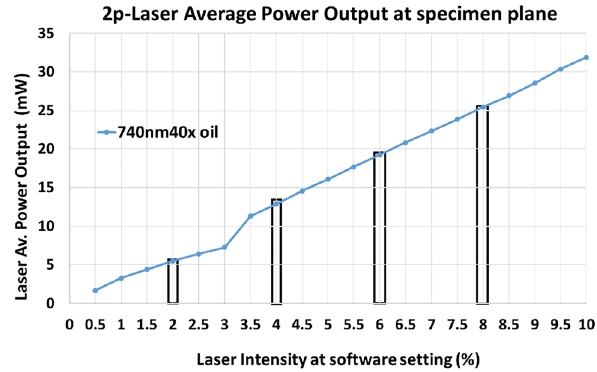
Figure 2. 2p laser average power measured at the specimen plane. The average power of 2p laser at 740 nm was measured using a slide power meter (ThorLabs) with a 40 × oil, 1.3N.A lens. Laser average power at the specimen plane was correlated with the power setting of the software controller. The bars are the respective average power used in current investigation to assess 2p-laser induced mitochondrial damage (see the text for